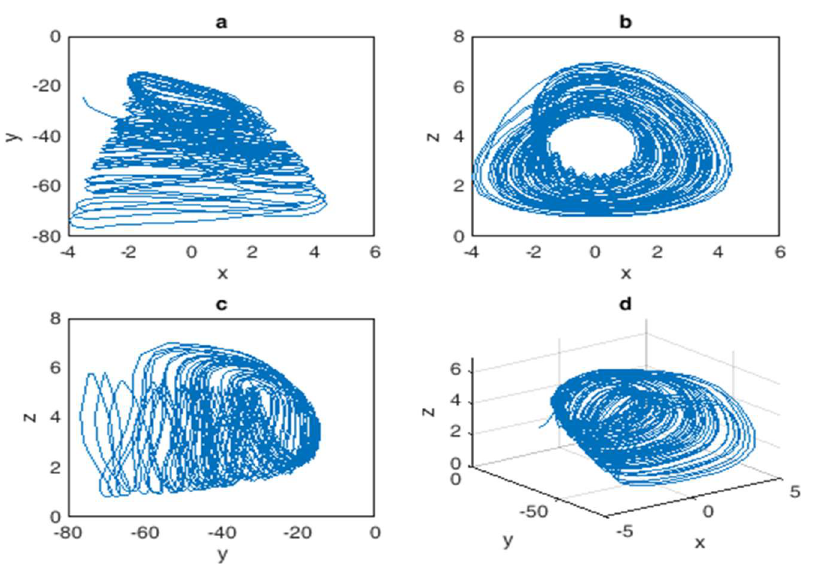
Figure 3. Chaotic attractors with external disturbance and uncertain parameter; ( a ) x - y plot, ( b ) x - z plot, ( c ) y - z plot, ( d ) x - y - z plot.